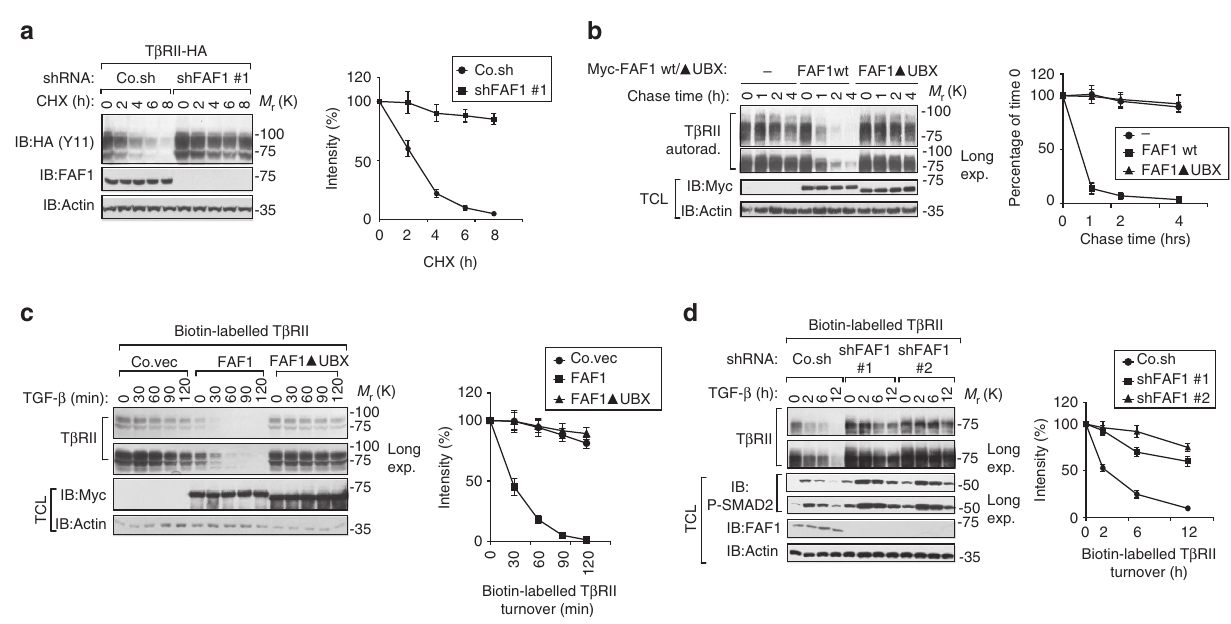
Figure 2 | FAF1 promotes T b RII turnover at the cell surface. ( a ) The immunoblot (IB) of cell lysate derived from HEK293T cells stably expressing T b RII-HA and depleted of FAF1 that were treated with CHX (20 m gml (cid:2) 1 ) at the indicated time points. The amount of protein after CHX treatment was expressed as a percentage of that present before treatment (time 0), and is shown in the right panel. The results are shown as the mean ± s.d. of three independent sets of experiments. ( b ) [ 35 S]-methionine labelling and pulse-chase analysis of T b RII in control and MDA-MB-231 cells stably overexpressing empty vector ( (cid:2) ), Myc-FAF1 wt or FAF1 m UBX (UBX domain-deleted mutants). The amount of labeled protein precipitated after the chase was expressed as the percentage of that at the beginning of the chase (time 0) and is shown in the right panel. The results are given as the mean ± s.d. of three independent sets of experiments. ( c , d ) IB of biotinylated cell surface T b RII in MDA-MB-231 cells stably overexpressing FAF1 wt/FAF1 UBX-deleted mutant ( m UBX) ( c ) or stably depleted of endogenous FAF1 by two independent shRNA (shFAF1 #1 and shFAF1 #2) ( d ) and treated with TGF- b (5ngml (cid:2) 1 ) at the indicated time points. Quantification of the band intensities is shown in the right panel. Band intensity was normalized to the t ¼ 0 controls. The results are presented as the mean ± s.d. of three independent sets of